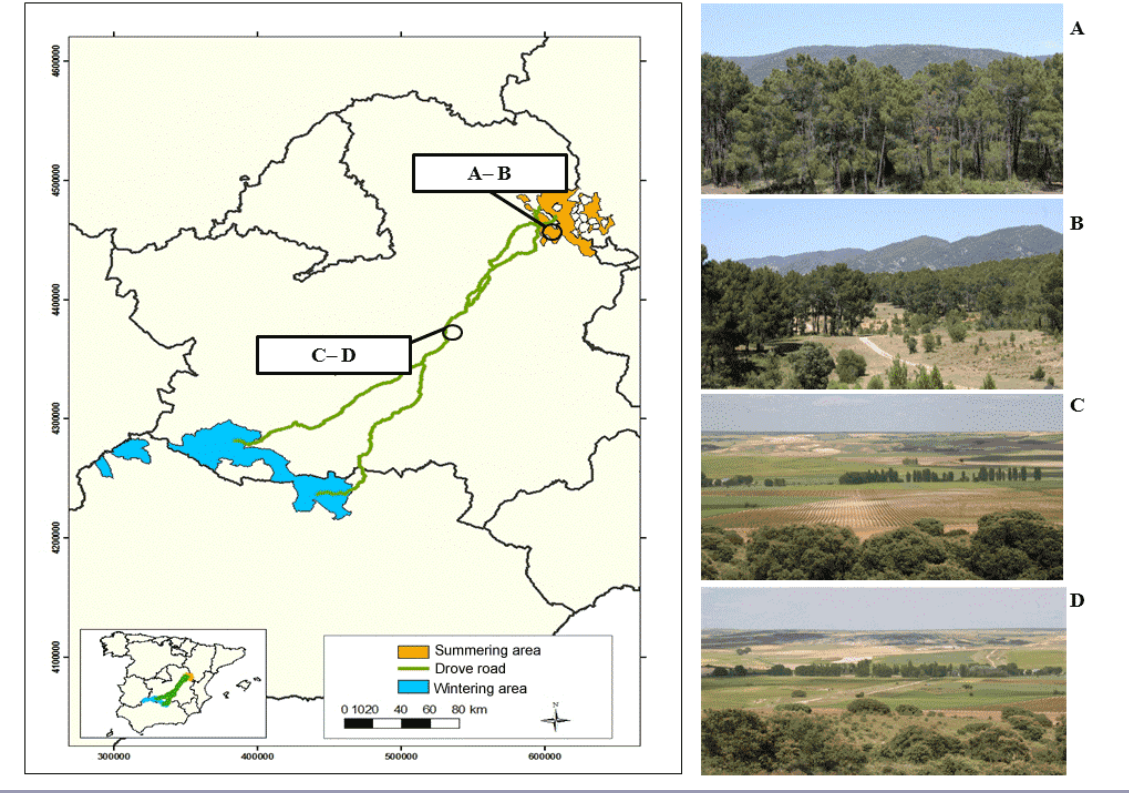
Fig. 1 . Map of the study area with the Conquense Drove Road (green) and the associated summering (yellow) and wintering (blue) areas. The two pairs of images used for exploring social perception of ecosystem services: forest landscape without the drove road (A), forest landscape with the drove road (B), cropland landscape without the drove road (C), and cropland landscape with the drove road